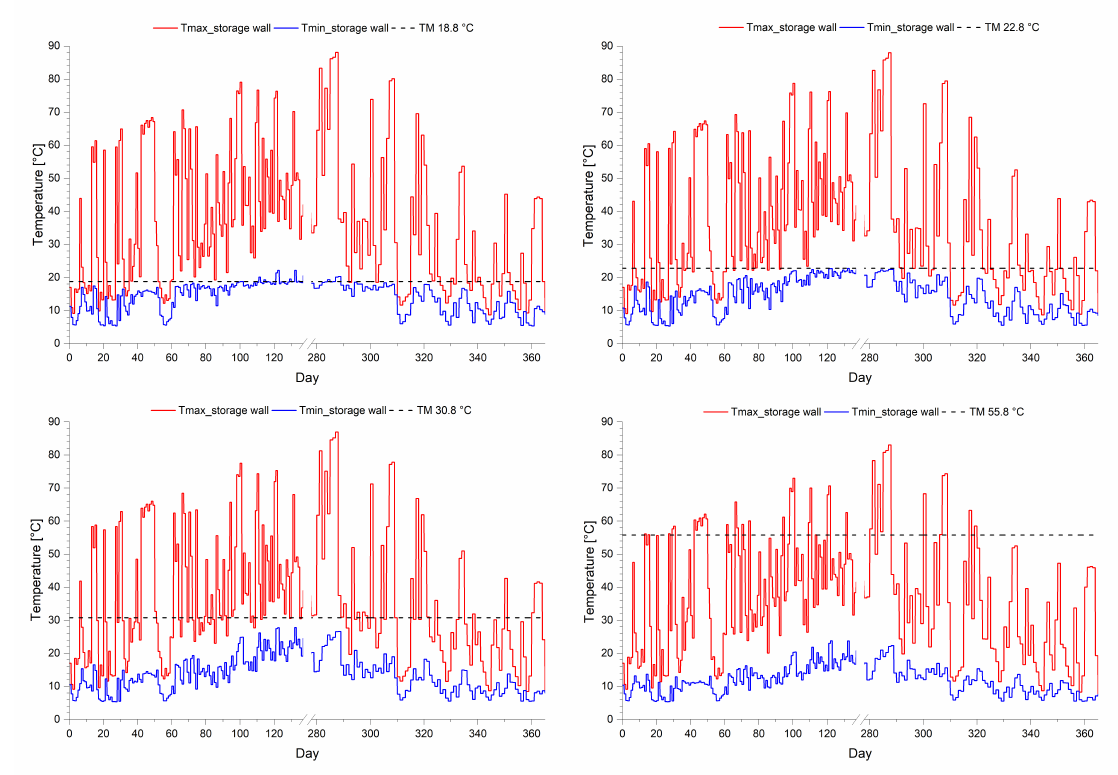
Figure 7. Daily amplitudes during the entire year of temperature fluctuations at the center of the PCM storage wall vs. four different values of PCM melting temperature. T max_storage wall and T min_storage wall denote respectively the daily maximum and minimum